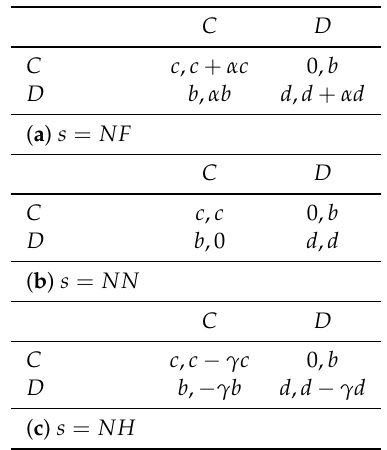
Table 2. Utility